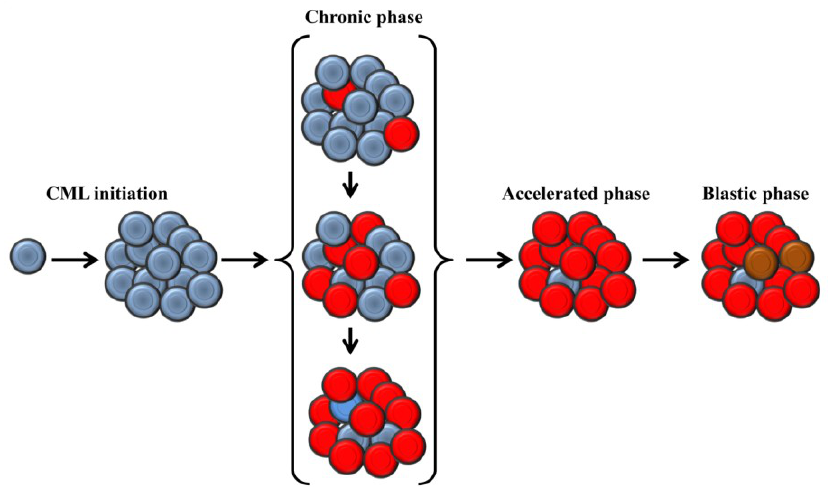
Figure 1. A Suggested model for telomere length maintenance during a course of CML progression. At the initiation of CML, leukemic cells use exclusively alternative lengthening of telomere (ALT) to maintain their telomeres. As CML progresses from an early to a late stage of the chronic phase, clones expressing telomerase become predominant. At the accelerated and blastic phases, the quasi totality of the cells expresses telomerase, but few ALT positive clones remain. At the blastic phase, clones expressing high activity of telomerase appear and become resistant to imatinib. Blue circles: Cells using ALT; Red circles: cells using telomerase; Brown circles: Cells expressing high telomerase activity and resistant to